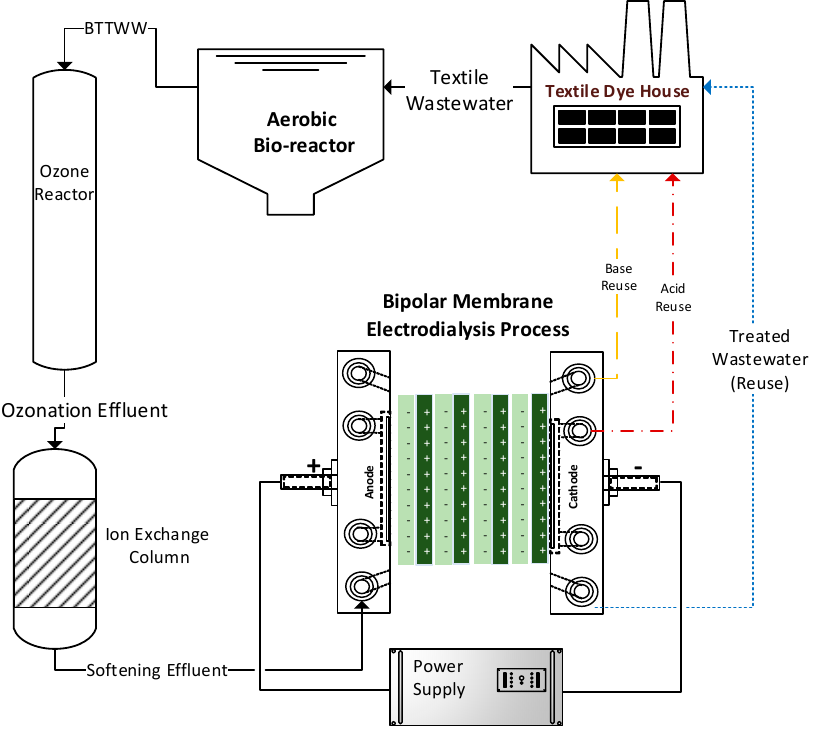
Figure 1. Schematic representation of the proposed treatment process for the textile